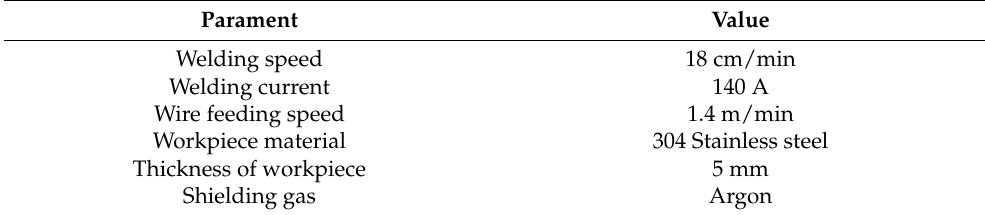
Table 1. Experimental paraments.